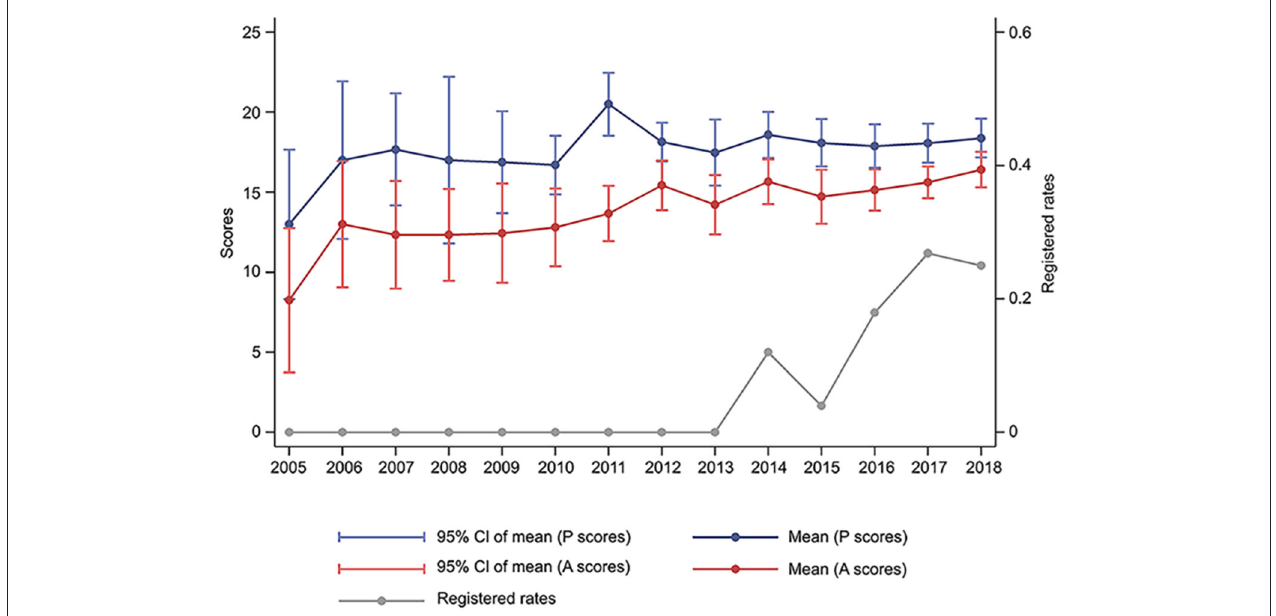
FIGURE 2 | Changes of the quality and registered rates of systematic reviews in type 2 diabetes mellitus between 2005 and 2018. P, Preferred Reporting Items for Systematic Reviews and Meta-analyses; A, Assessment of Multiple Systematic Review 2.